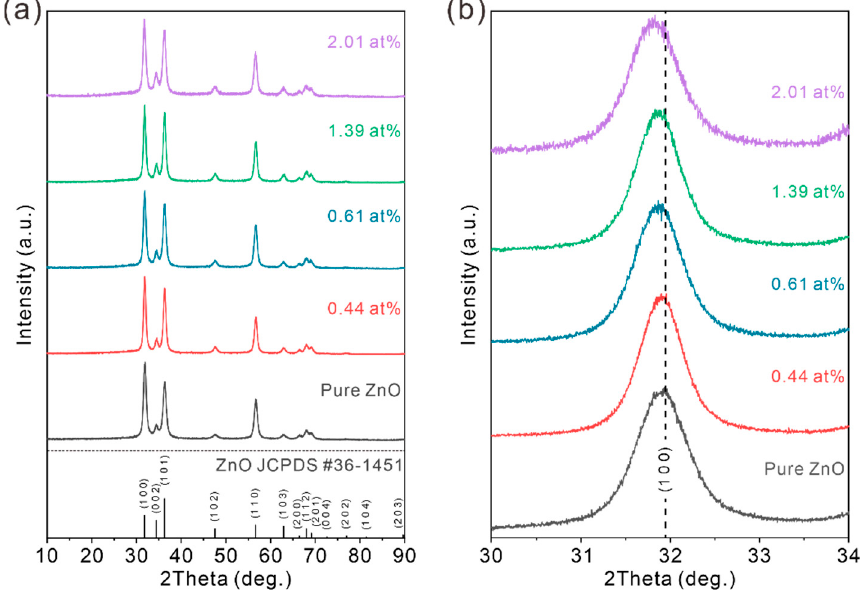
Figure 3. ( a ) XRD patterns of the as-prepared pure ZnO and 0.44 at%, 0.61 at%, 1.39 at% and 2.01 at% Pb-doped ZnO, and ( b ) their corresponding high-resolution XRD patterns at the main diffraction peak of (100).